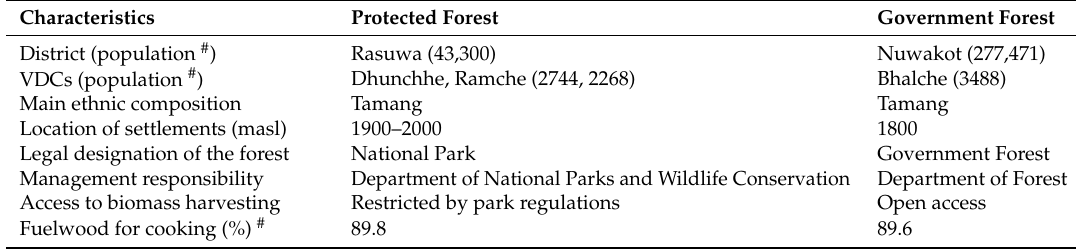
Table 1. Characteristics of the two sampled forest areas; inside (Protected Forest) and outside (Government Forest) legal protection in the Langtang area of Nepal. Masl = meters above sea